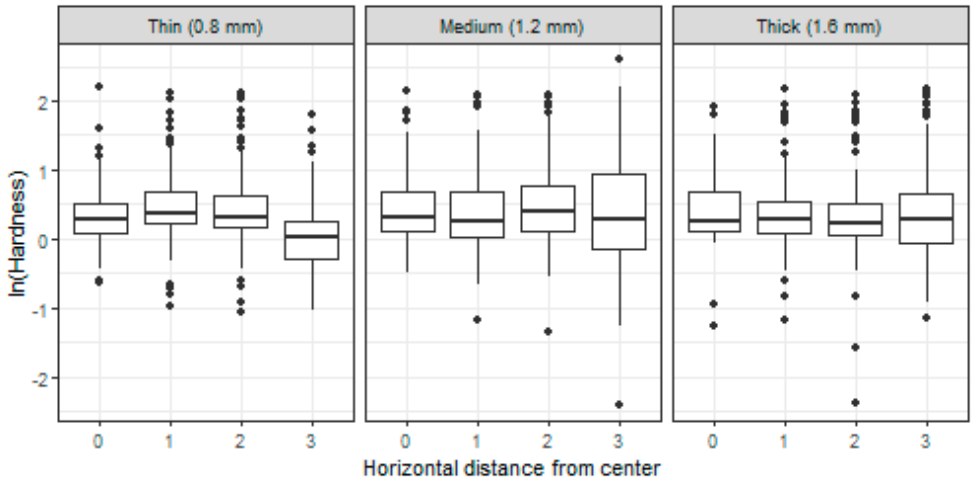
Figure 2. Boxplots of (log-)hardness measured on specimens with different root canal wall thickness (0.8, 1.2, and 1.6 mm) and in different distance from the center of a specimen (0–center,